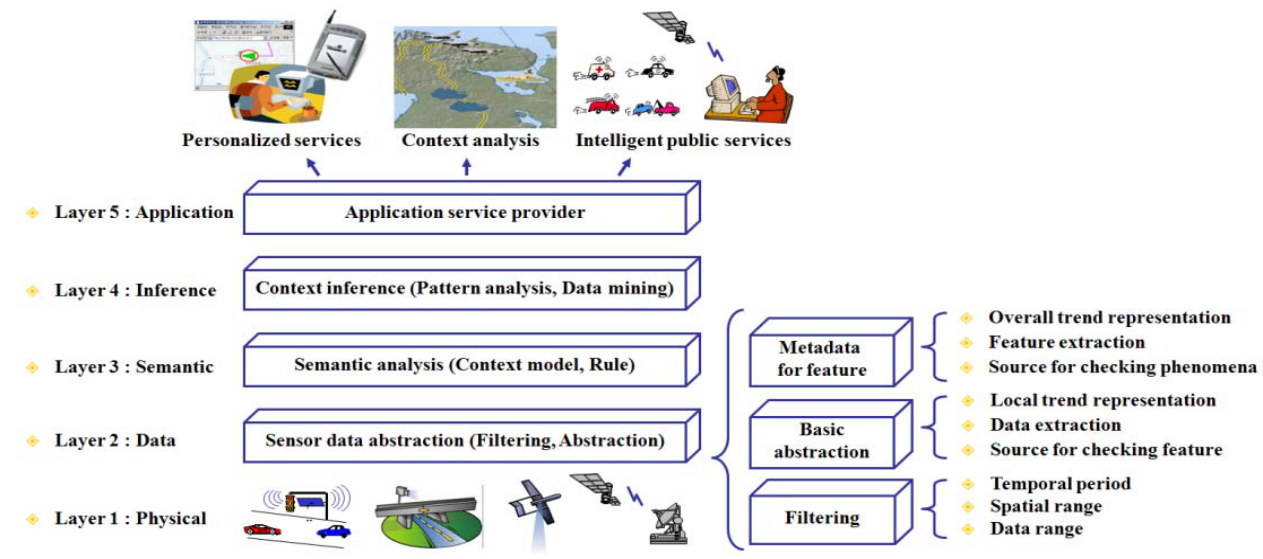
Figure 1. The data processing step in environmental monitoring